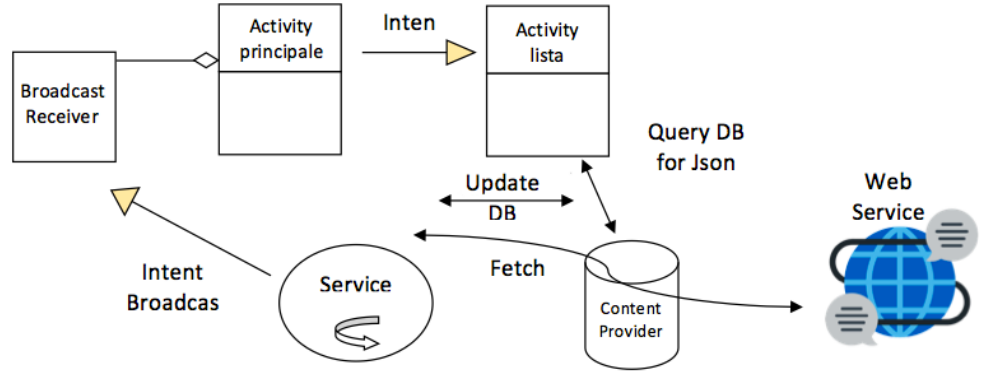
Figure 10. Smart cabin